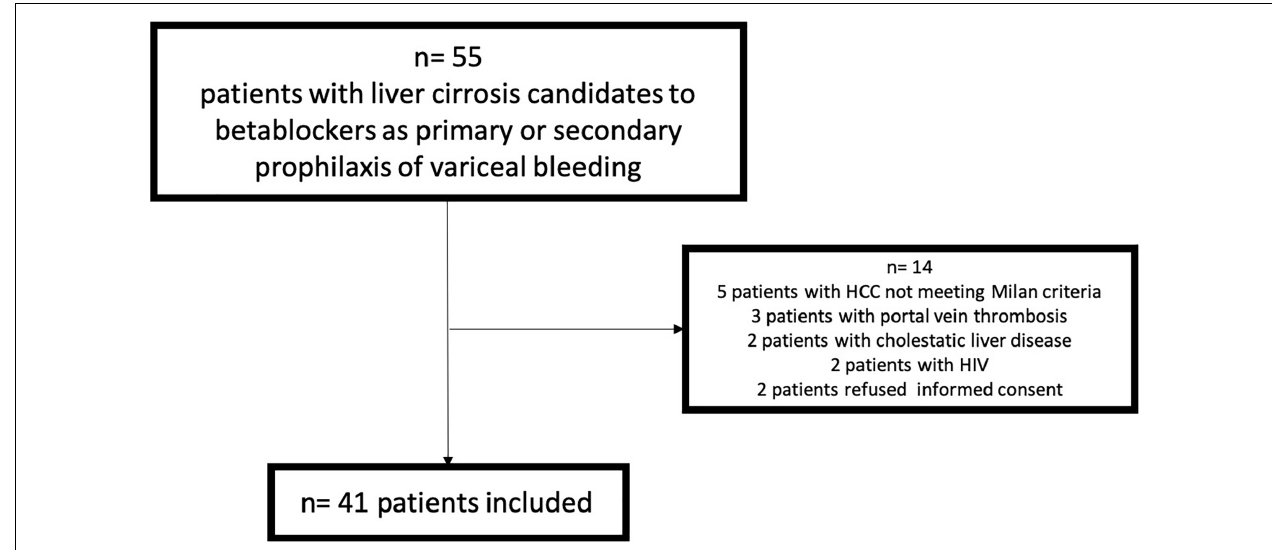
FIGURE 1 | Flow chart of the